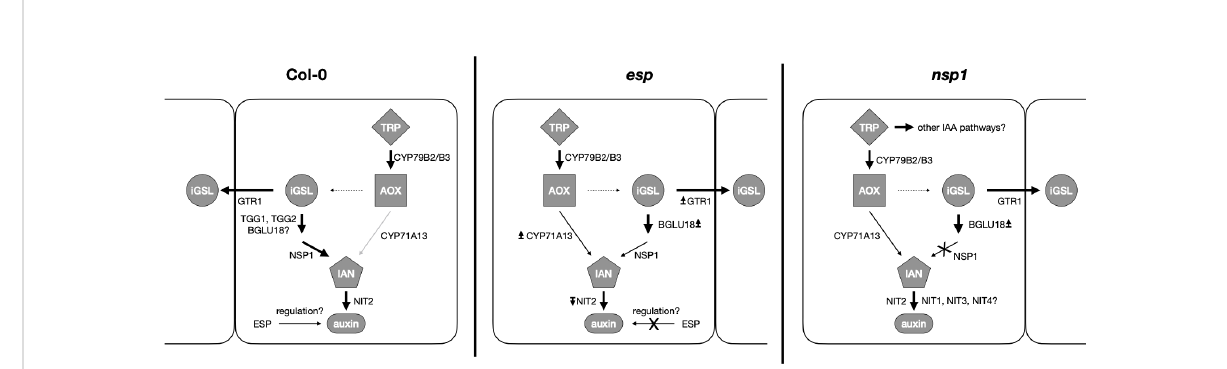
FIGURE 9 Expression patterns in control and drought-stressed Col-0, esp and nsp1 Arabidopsis thaliana plants. TRP=tryptophan, AOX=Indole- acetaldoxime, iGSL=indolic glucosinolates, IAN=indole-3-acetonitrile, auxin=iGSL derived carboxylic acids. Bold arrows indicate signi fi cantly higher expression, light grey arrows indicate lower expression in severely drought-stressed compared to control plants. Arrows near enzymes indicate higher ( ↥ ) or lower ( ↧ ) expression of genes compared to Col-0. Dashed arrow indicates synthesis steps involving multiple genes. In Col- 0 genes expressing proteins responsible for the degradation of glucobrassicin and converting its breakdown products are highly expressed in drought-stressed plants compared to controls. In esp , auxin synthesis is redirected towards synthesis directly from AOX. Unchanged expression of CYP71A13 and NIT2 in nsp1 mutants indicates the involvement of other nitrilases leading to depletion of IAN or complete redirection of IAA synthesis to other